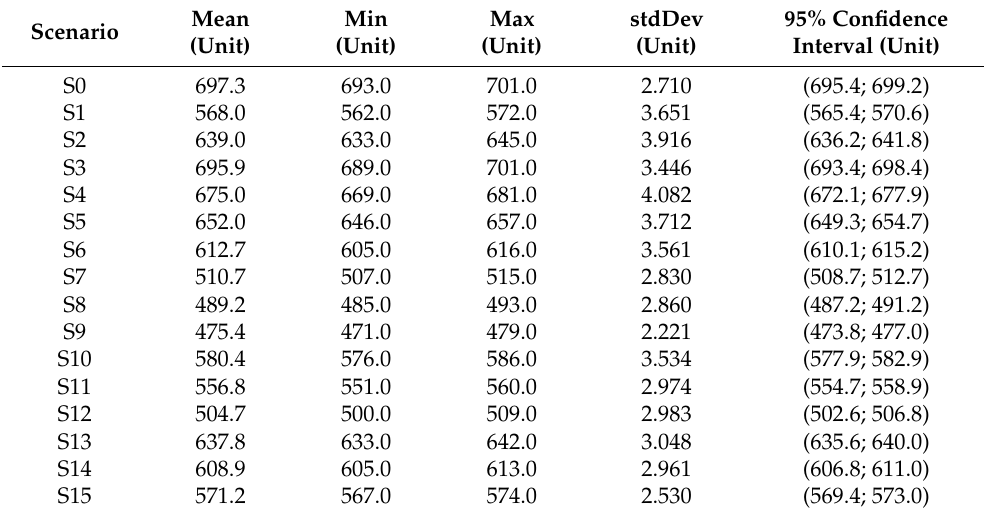
Table 3. Monthly productivity of the manufacturing system under the scenarios